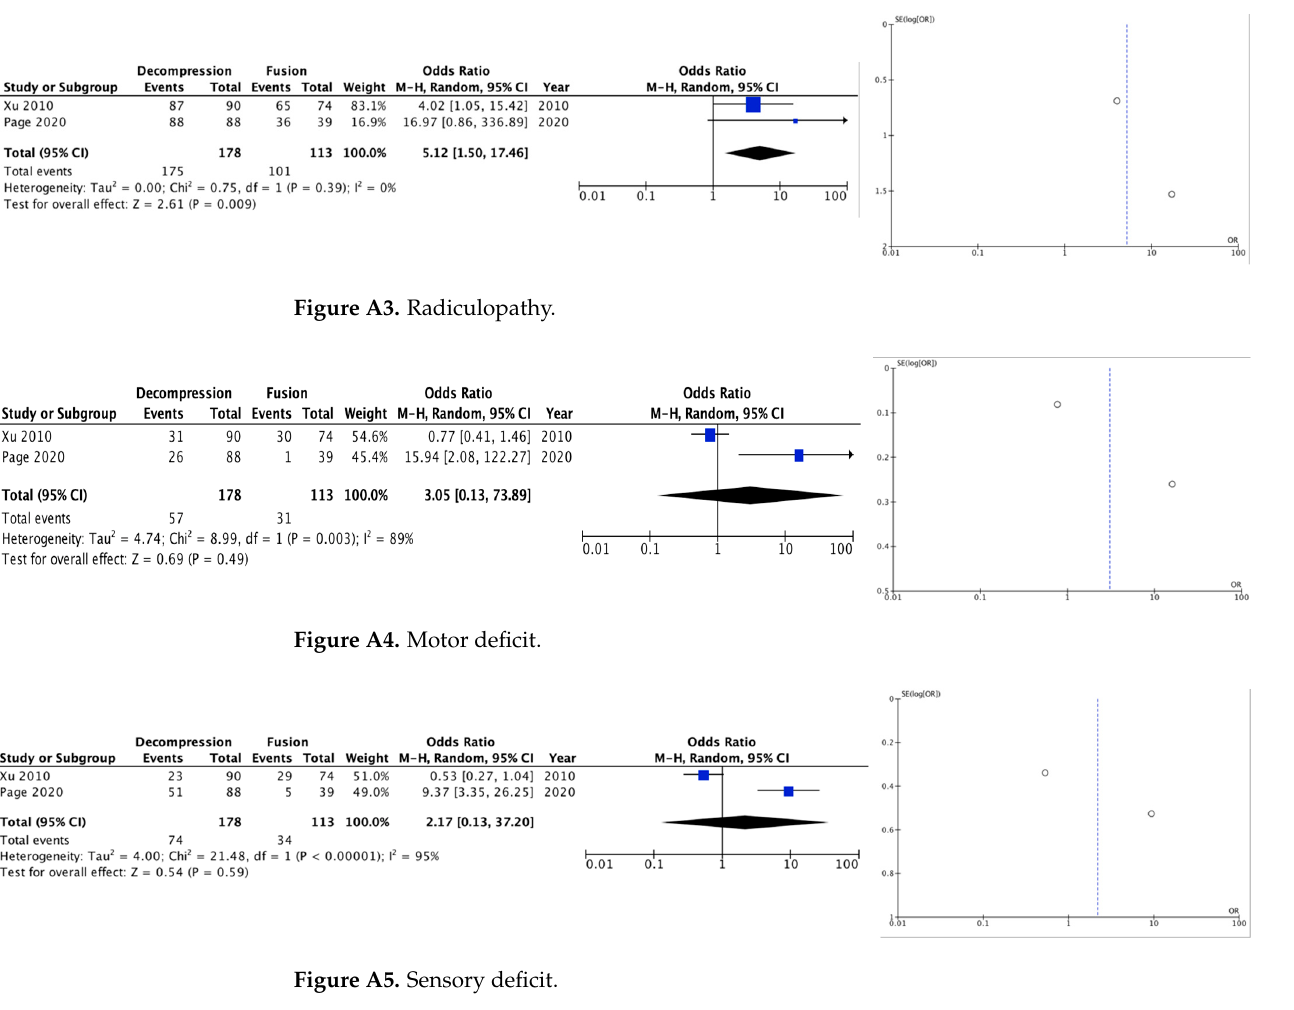
Figure A2. Back pain.